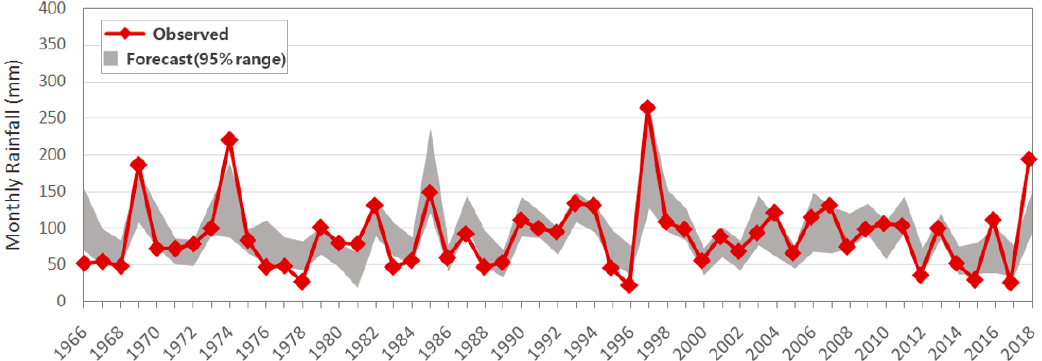
Figure 5. 95% prediction uncertainty interval of the monthly rainfall in May.